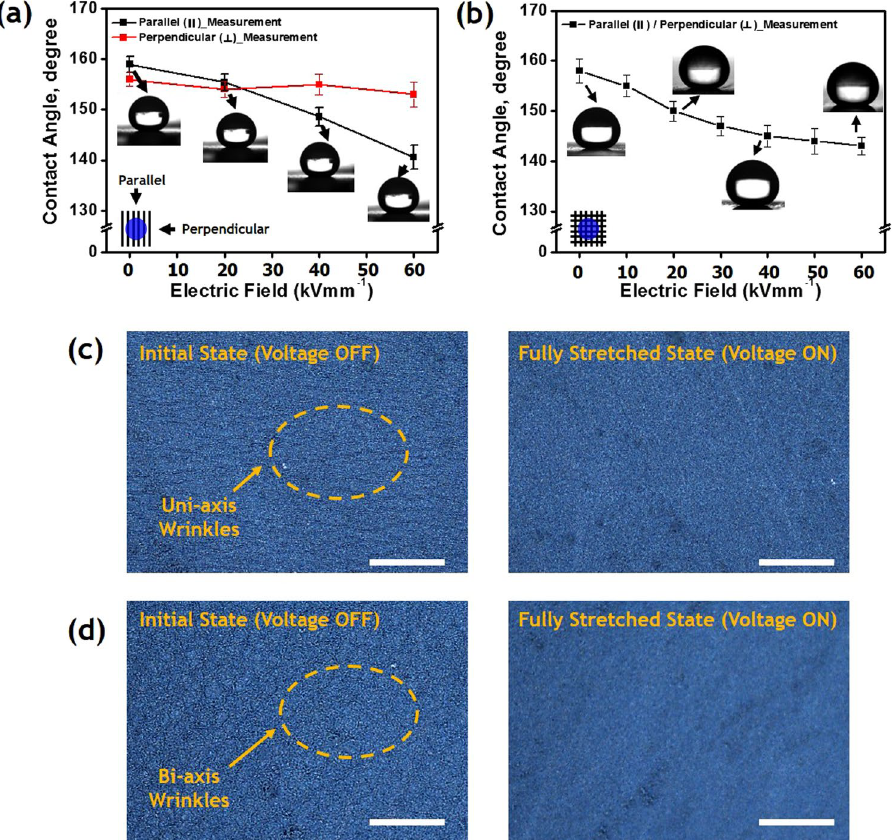
Figure 5. Anisotropic and isotropic wettability control due to surface modification of winkled elastomer actuator: contact angle variation of a water droplet on ( a ) uni-axial, and ( b ) bi-axial wrinkled surface; and microscopic observation of wrinkled surface modification under WDEA actuation: ( c ) uni-axial and ( b ) bi- axial wrinkled surface (Scale bar = 100 μ